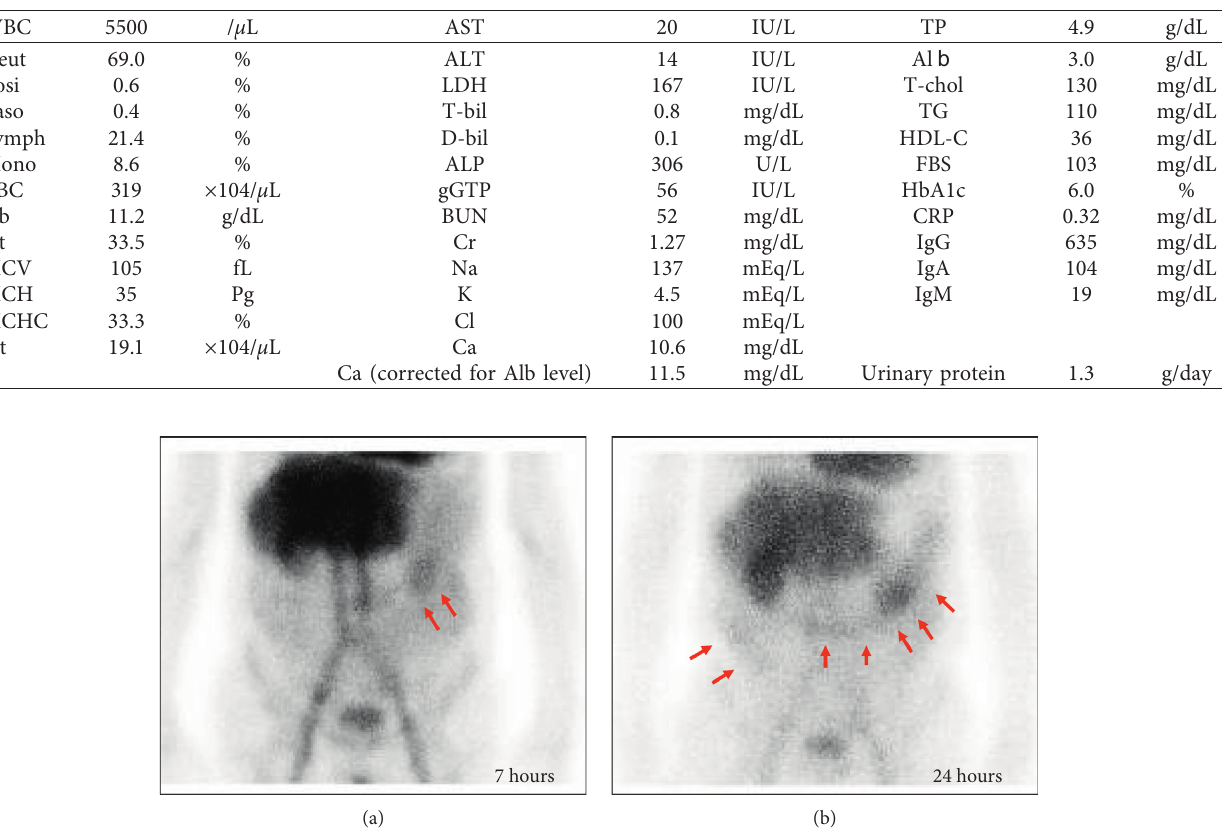
Table 1: Laboratory data on admission.